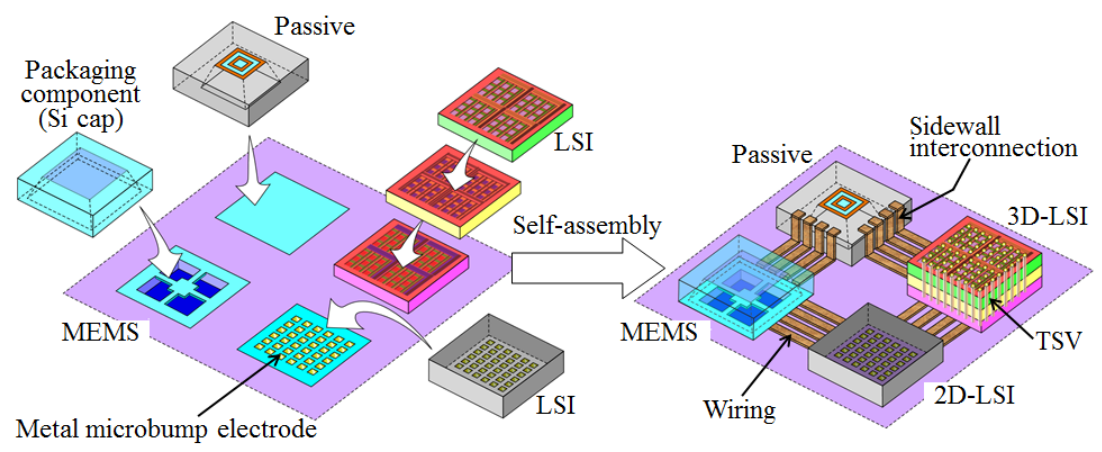
Figure 1. Self-assembly of various kinds of chips with/without cavity structures for MEMS-LSI 3D and hetero